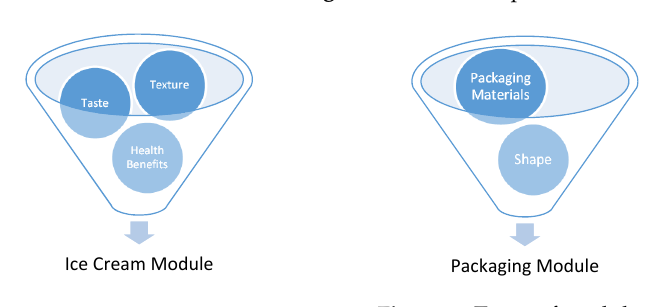
Figure 3. Types of modules.